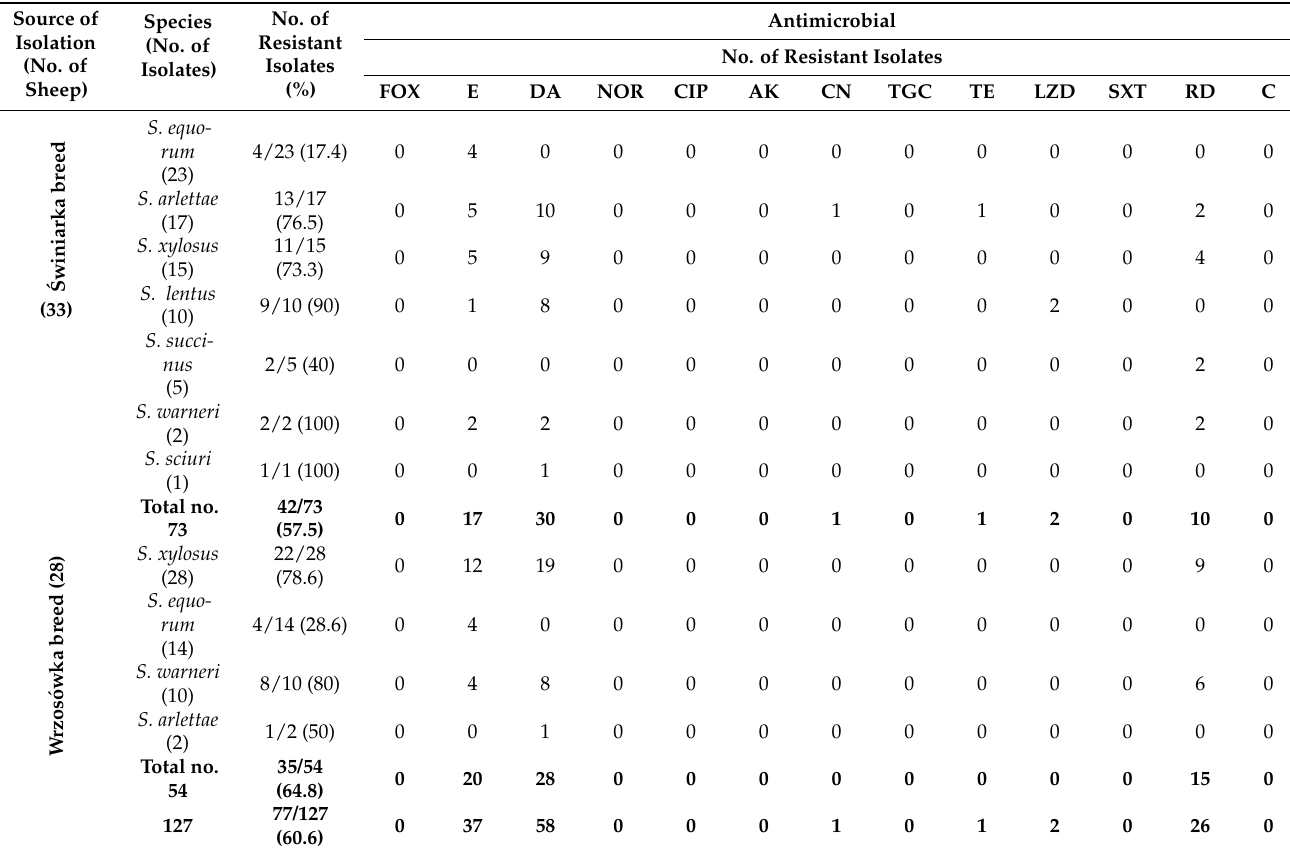
Table 6. Relationship between a source of isolation and antimicrobial resistance of staphylococci.